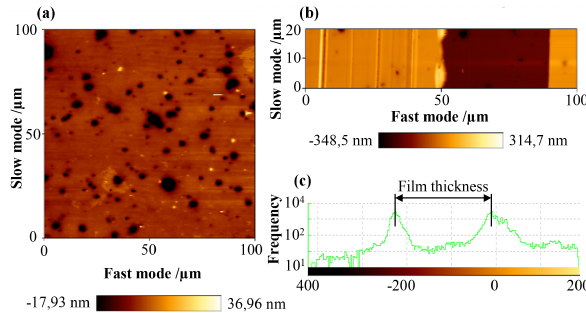
Figure 3. AFM image of (a) the hydrogel surface and (b) a scratch for the determination of the layer thickness with (c) the correspond- ing height